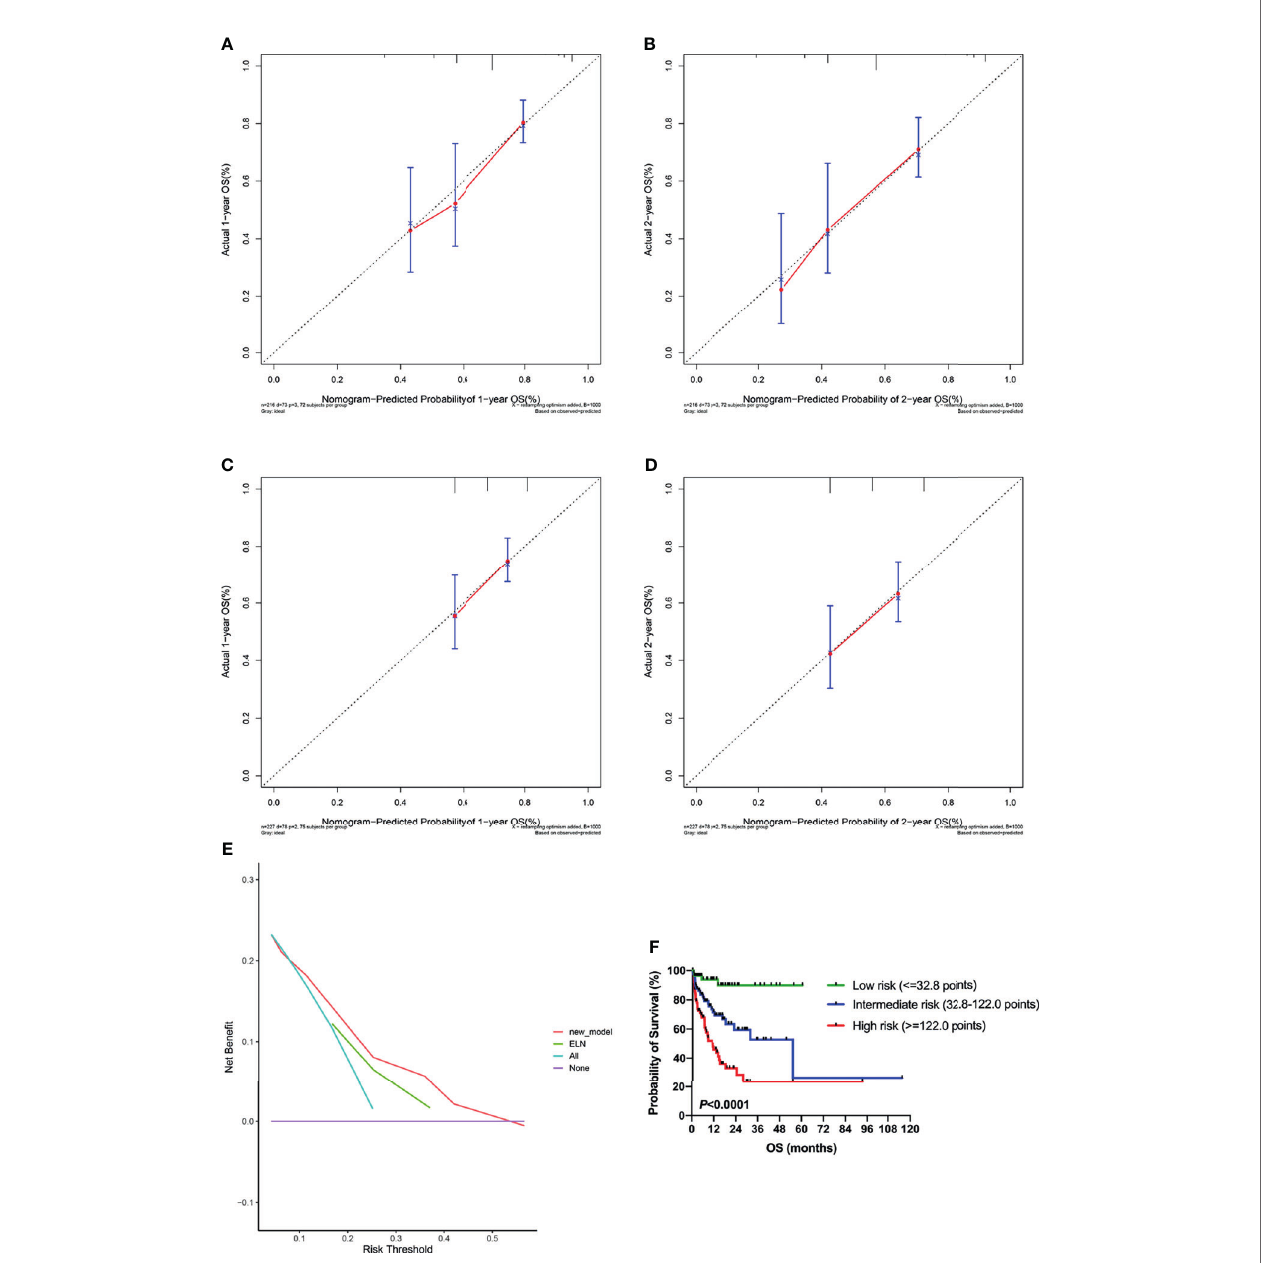
FIGURE 6 | Validation of the nomogram. (A, B) Calibration curves showed predicted and actual 1-year and 2-year survival probabilities by the nomogram. The gray diagonal dotted line indicates the perfect correspondence between the observation and prediction. (C, D) Calibration curves showed predicted and actual 1-year and 2- year survival probabilities by the 2017 ELN risk strati fi cation (low, intermediate, and high risk). (E) Decision curve analysis (DCA) for the nomogram and 2017 ELN risk strati fi cation in prediction of prognosis of AML patients. (F) Kaplan-Meier plots for overall survival according to the nomogram score. ELN, European Leukemia